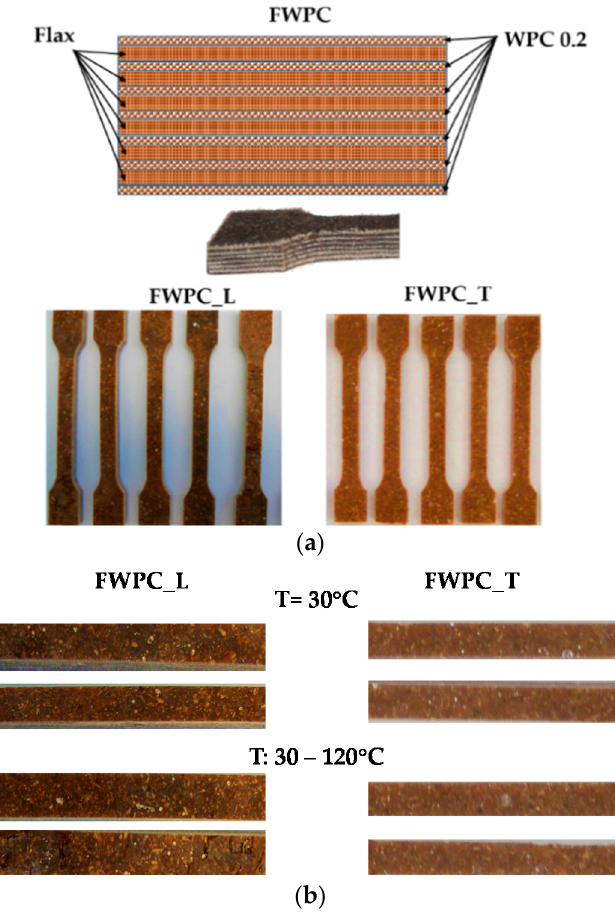
Figure 3. The specimens made from flax and wood particles reinforced and polyester resin: ( a ) samples for tensile test: FWPC_L—samples cut in longitudinal direction; FWPC_T—samples cut in transversal direction; ( b ) samples for DMA test.